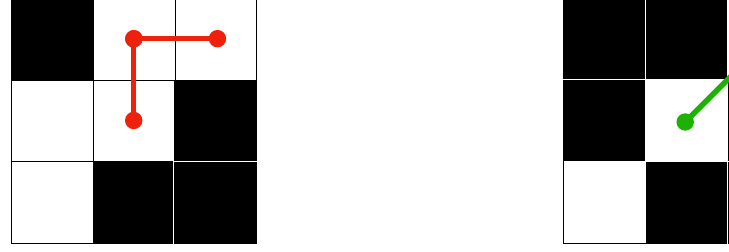
Figure 3. To the left , an incorrect measurement due to a step-like connection with a distance of 2, to the right , the corrected centerline with a measured distance of